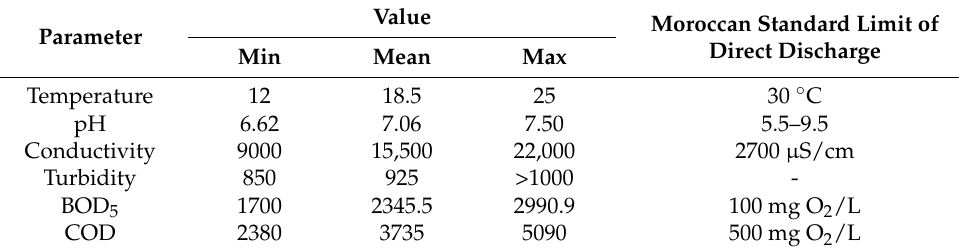
Table 3. Physicochemical characterization of FW